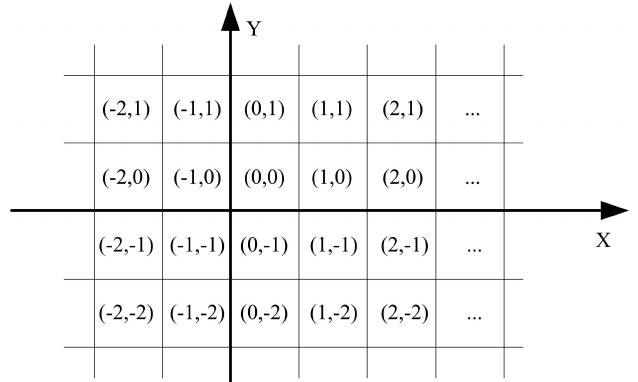
Figure 2. Definition of tile codes [Z,X,Y], where Z is tile level, for levels 1–5, and X and Y are integers. X is the horizontal coordinate and Y is the vertical coordinate. Each tile is labeled according to the coordinate of its lower left corner. Tile coordinates (X,Y) are under a level Z map.